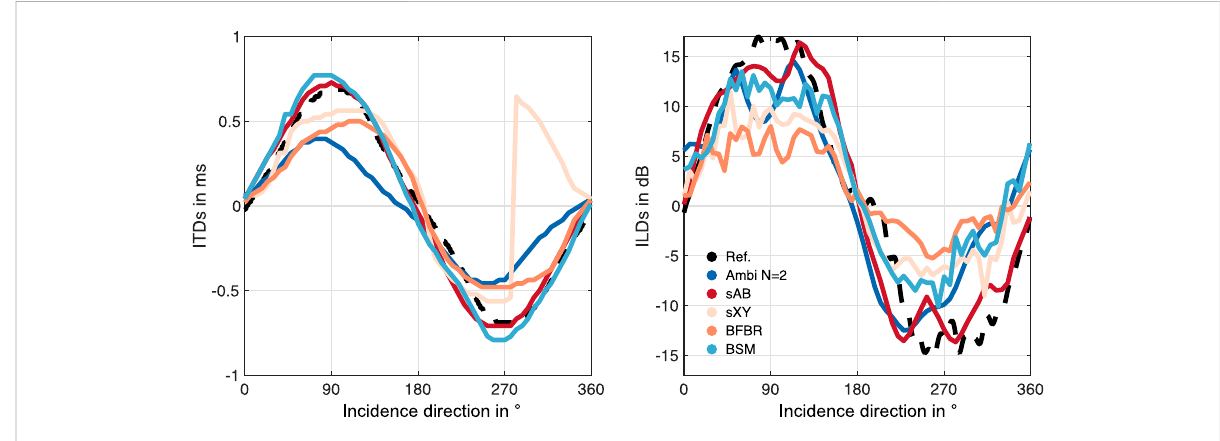
FIGURE 8 ILDs and ITDs of the glasses array using different binaural reproduction approaches. The reference values (black dashed lines) were calculated from the KEMAR HRTFs.